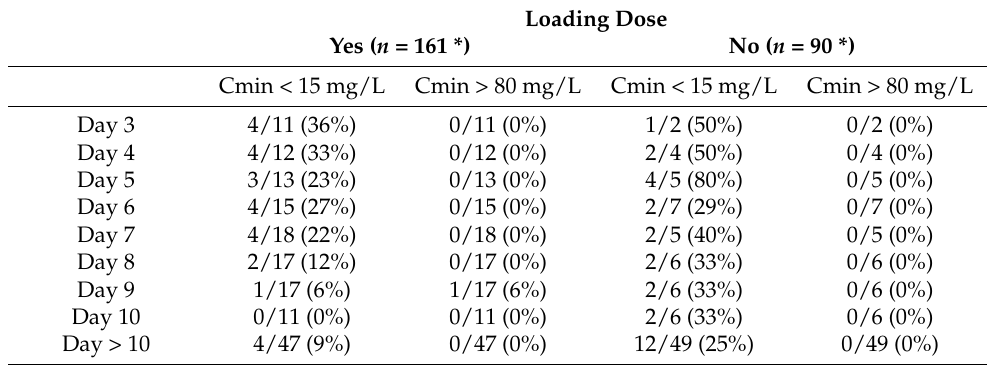
Table 4. Target nonattainment, depending on loading dose and day of fluconazole